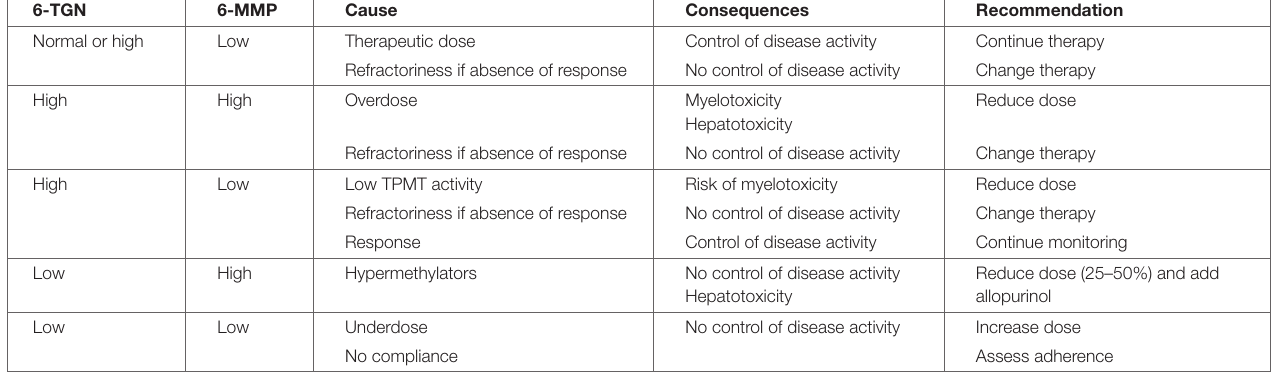
TABLE 2 | Thiopurine monitoring based on